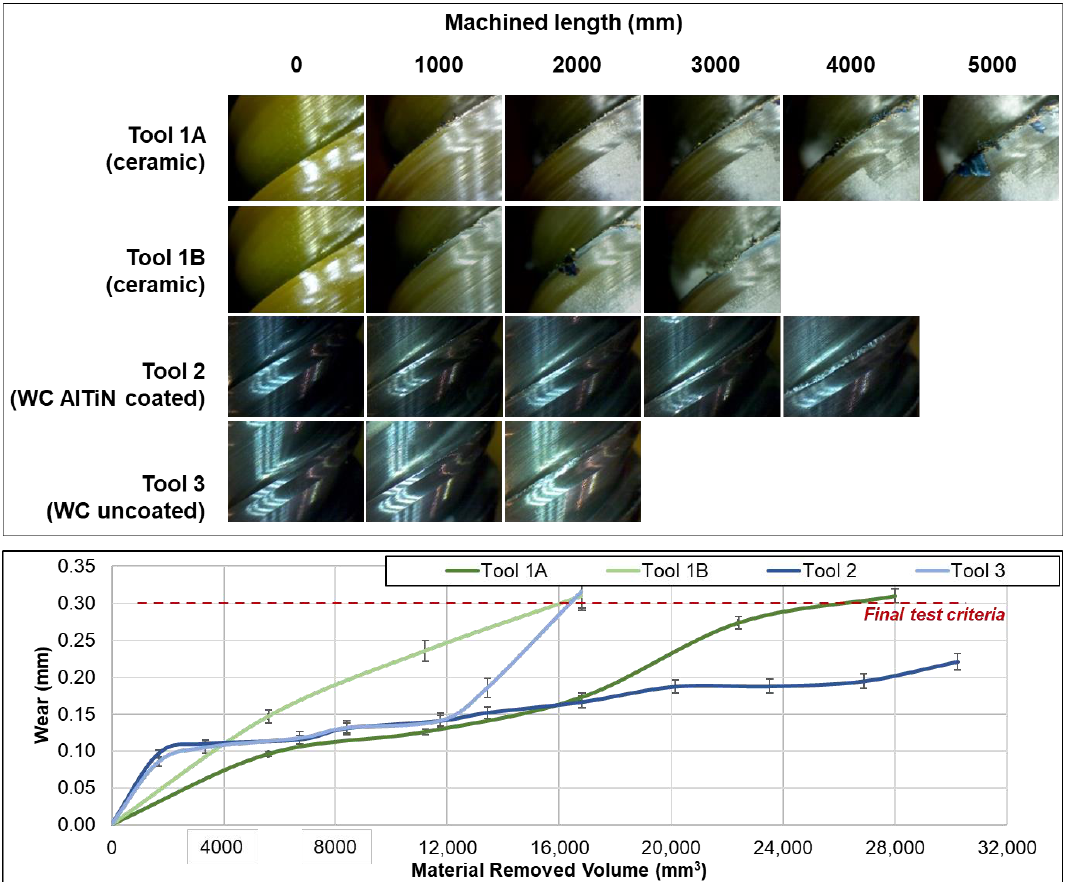
Figure 2. Tool wear evolution. These are the average value of three-test repetition. In the case of both ceramic tools, they presented three types of tool wear. At